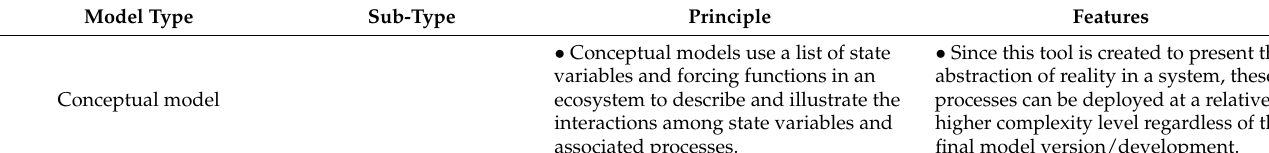
Table 1. Model classification and description of different model